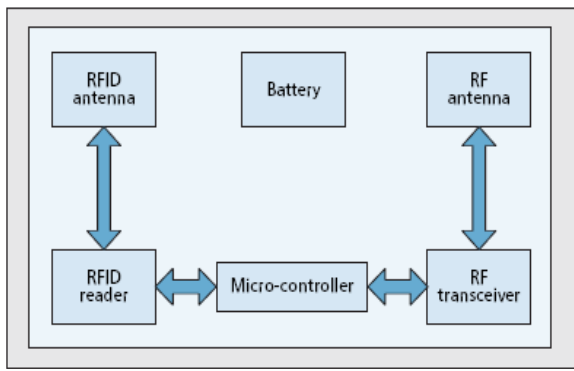
Figure 1. Integrated WSN node and RFID